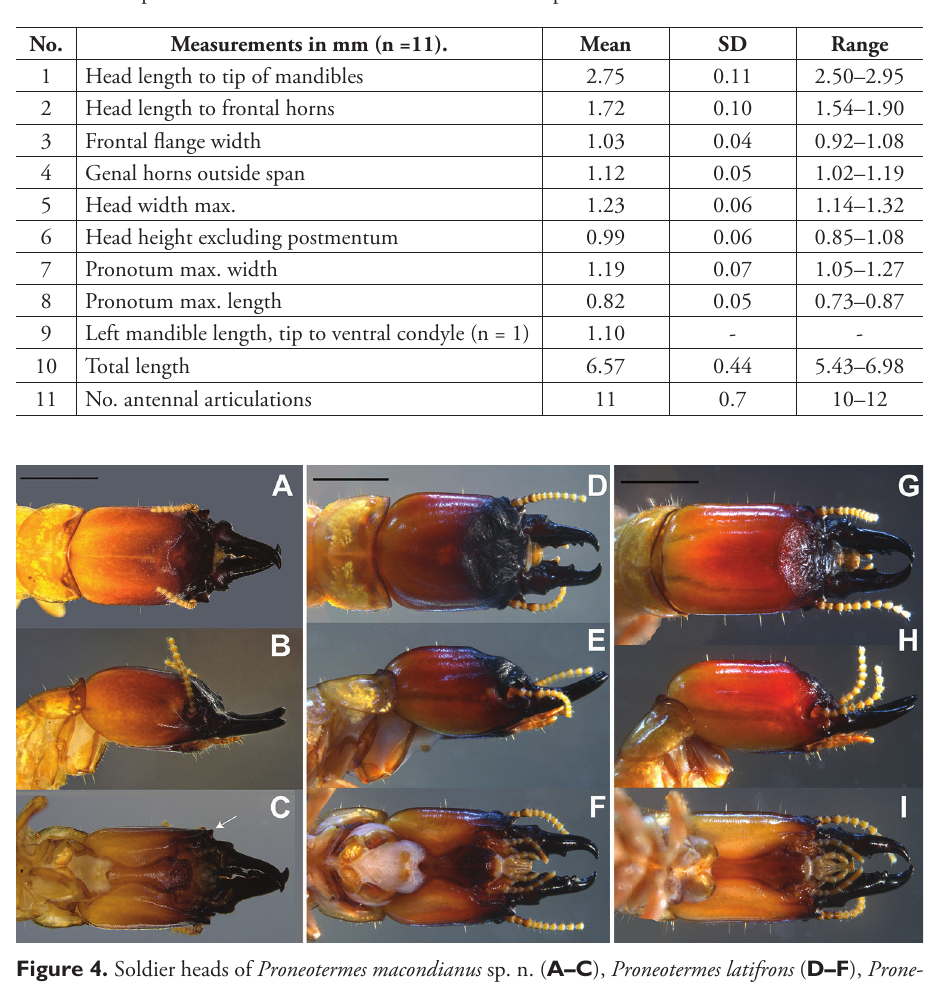
Table 3. Morphometrical measurements for P. macondianus sp. n. soldiers.